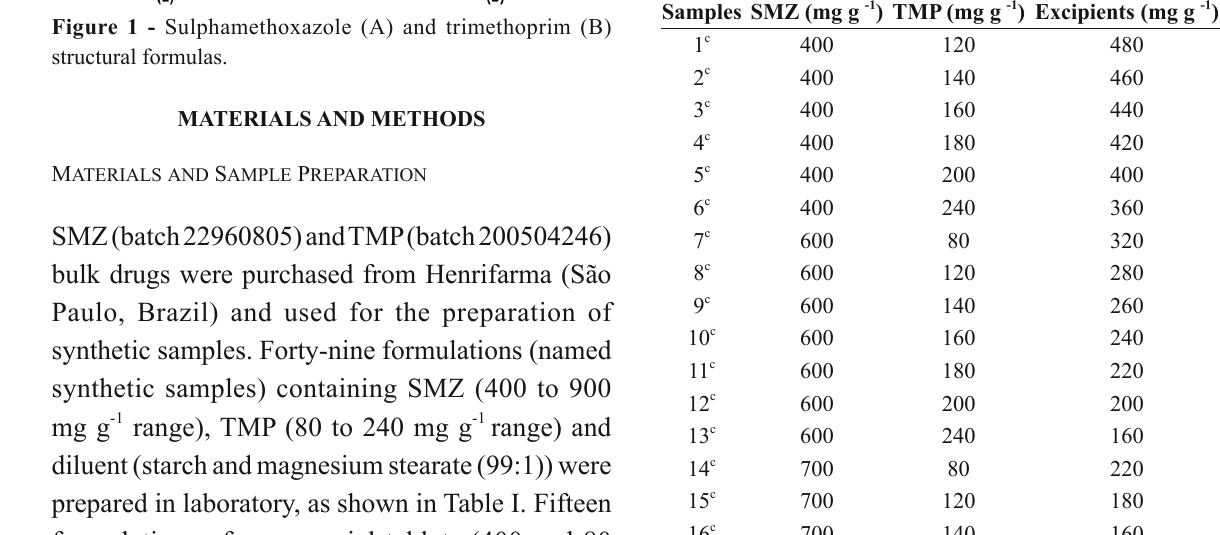
Synthetic samples used in calibration and prediction sets.